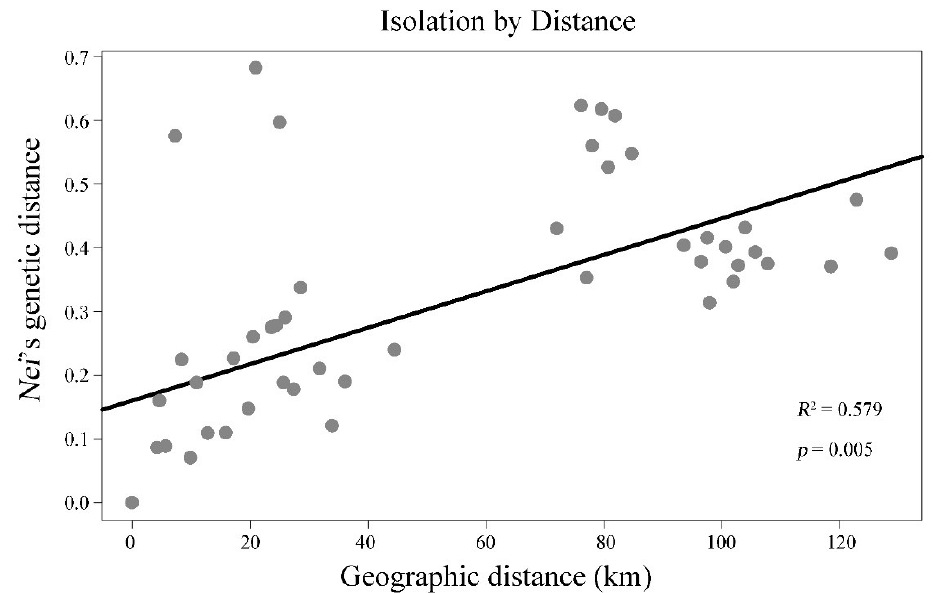
Figure 7. Relationship between the genetic distance and geographic distance among the studied carp populations.